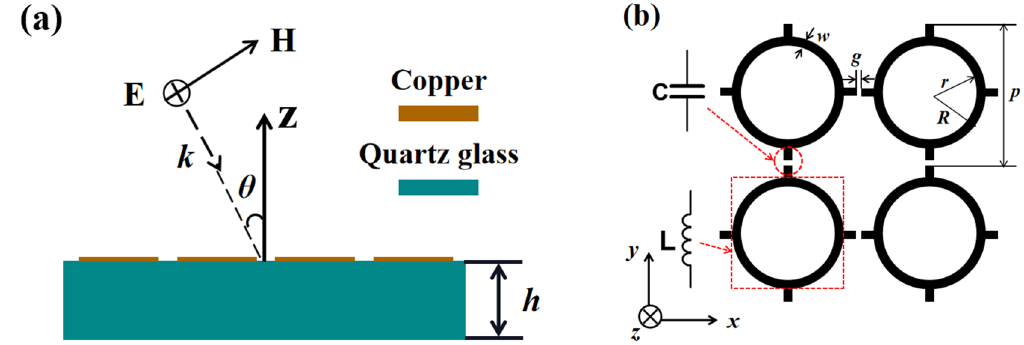
Figure 1. ( a ) Side view of the proposed FSS; ( b ) geometry of metallic array.